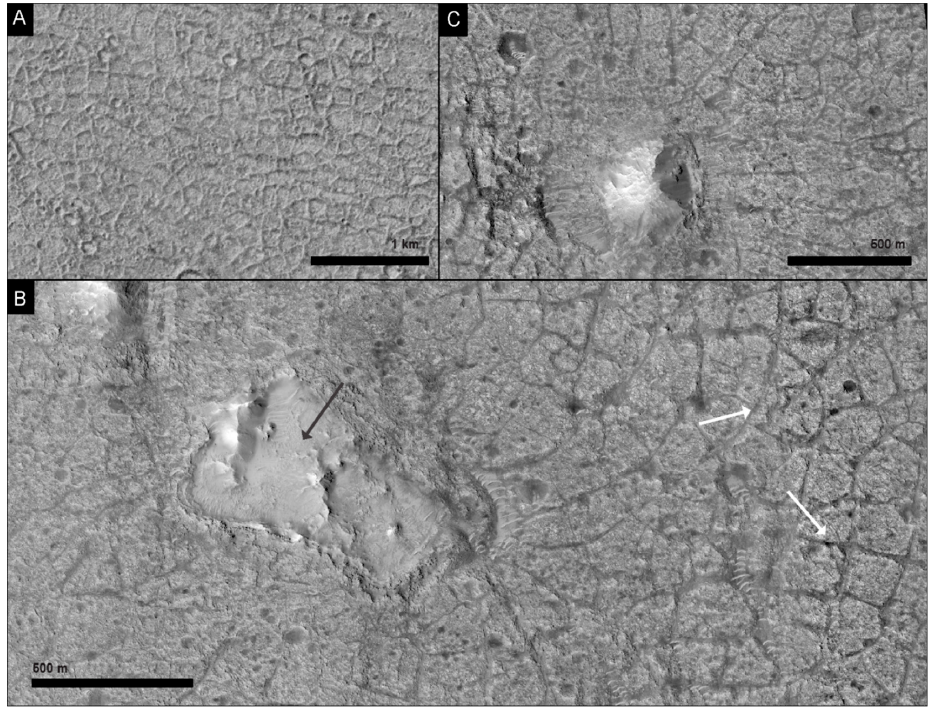
Figure 7. Polygonal patterns in the lowest elevation interior of Galilaei crater. ( A ) Polygonal terrain with raised ridges defining the polygons. CTX Image mosaic basemap. ( B ) Polygonal terrain defined by negative relief fractures in the surface (white arrows) is sometimes interrupted by depressions (black arrow) at the same scale as the chaos blocks. Erosion after the drying of Galilaei crater may have removed block material, leaving the depressions behind. ( C ) Fractures in the polygonal terrain radiate outward from a small mound that is part of distal chaos terrain. ( B , C ) are from HiRISE image ESP_068377_1855.